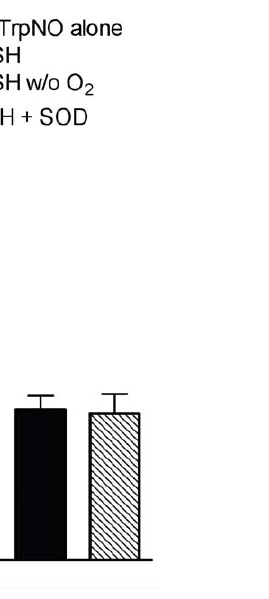
Figure 4. Formation of nitrite (NO 2 2 ) and nitrate (NO 3 2 , panel A), glutathione disulfide (GSSG, panel B), and S-nitrosoglutathione (GSNO, panel C) during NANT decomposition. N -acetyl nitroso Trp (100 m M) was incubated with GSH 1 mM for 30 min in the presence or absence of O 2 and SODat 37 u C and product formationwas determined by anionpairing HPLC. The values represent the mean 6 SEM (n=5–9); ND = not detectable. doi:10.1371/journal.pone.0014400.g004 Table 1. Detector response obtained from the reaction of N- acetylated L-amino acids by NO in oxygenated